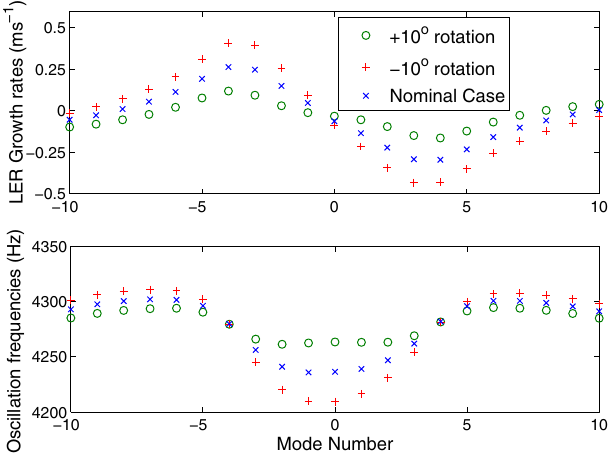
FIG. 10. (Color) Direct loop phase: (cid:2) 10 (cid:12) rotation in green, (cid:1) 10 (cid:12) rotation in red, and the nominal case for reference in blue.